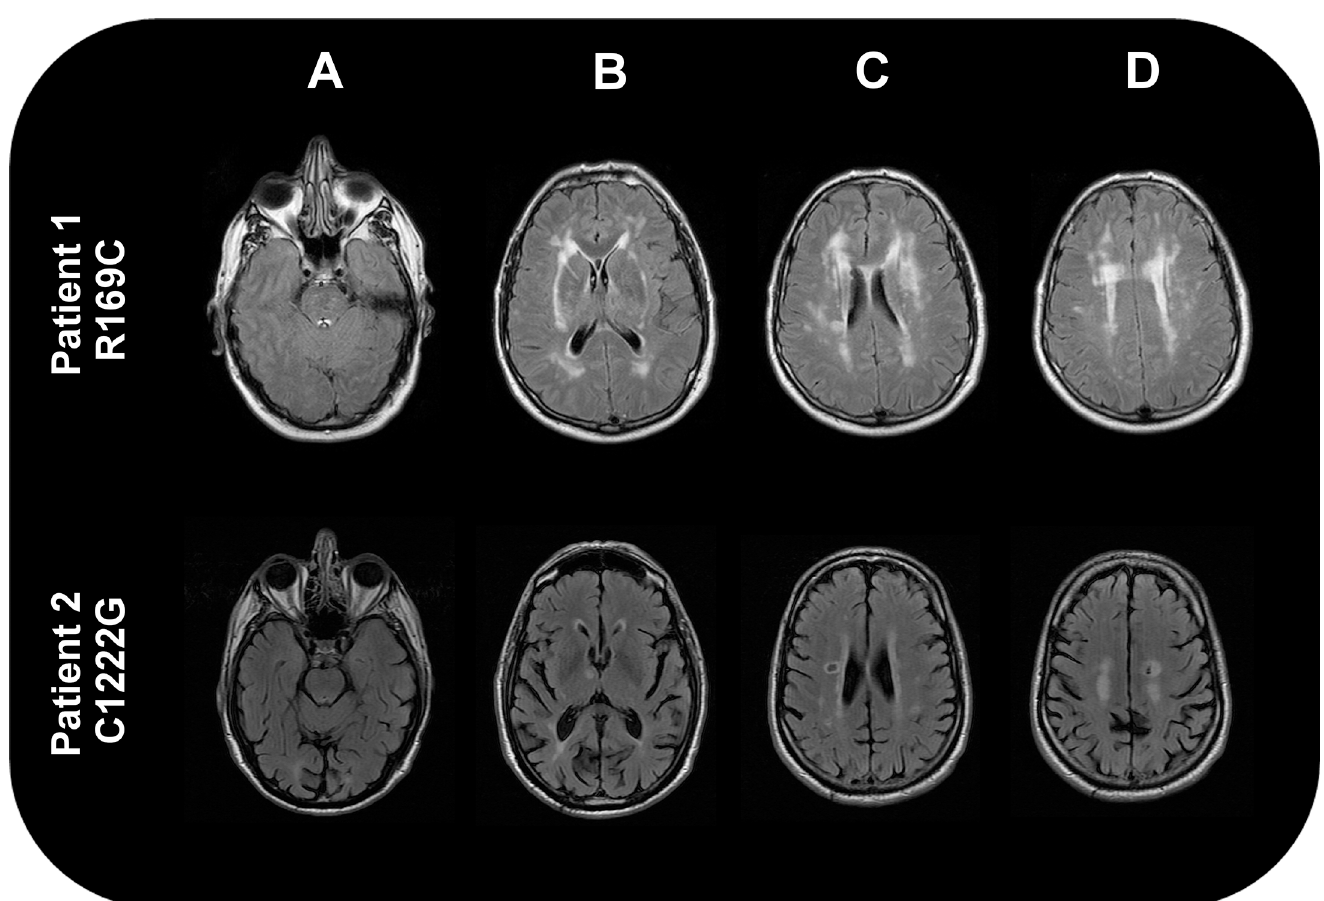
Fig 1. FLAIR Brain MRIs scans from two of the patients with notch 3 mutations. The upper panel 1 shows images from patient 1 (R169C), and the lower panel two shows images from patient 2 panel 2 (C1222G). These show leukoaraiosis in both cases (images C and D) but minimal anterior pole involvement in patient 1 (image upper panel A) and no involvement in patient 2 (image lower panel A). Patient 1 also shows confluent external capsule involvement (image B), but this is absent from patient 4 (lower panel